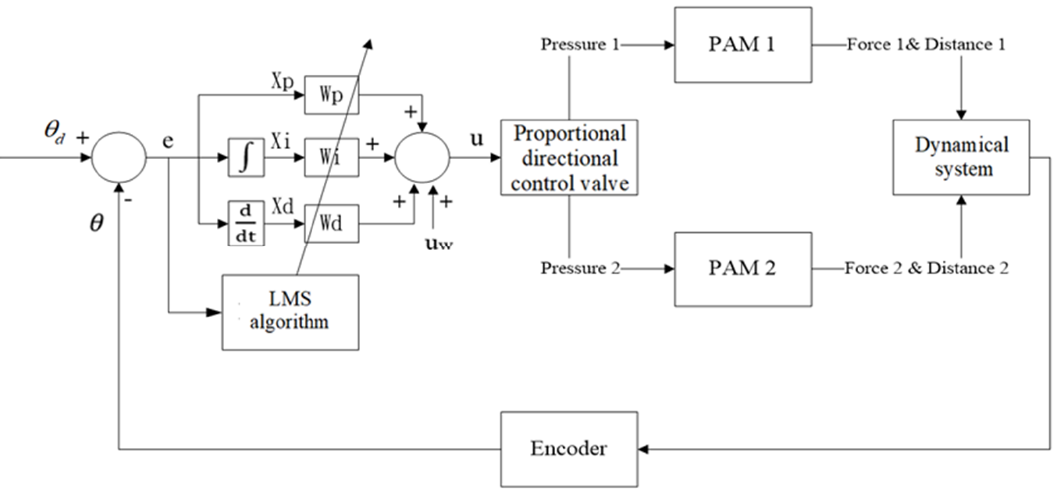
Figure 8. Flow chart of LMS-PID controller applied to proportional directional control valve.